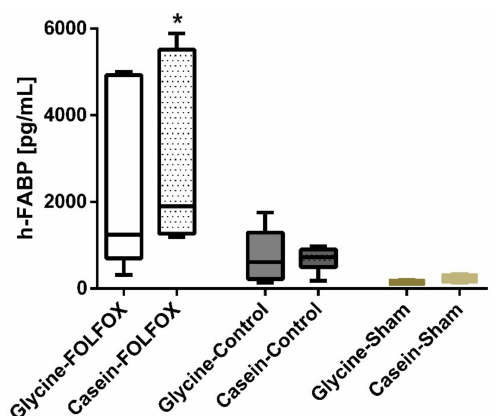
Figure 3. Serum levels of heart fatty acid binding protein (h-FABP) on the last experimental day. h-FABP level measured on the last experimental day was di ff erent between the study groups. * p <